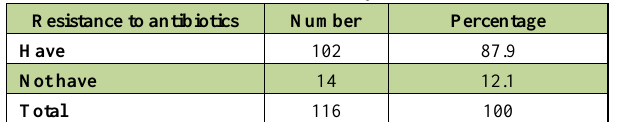
Table 3. Frequency Distribution of Resistance to antibiotics of Patients Admitted to ICU Burn Center of Rasht City.